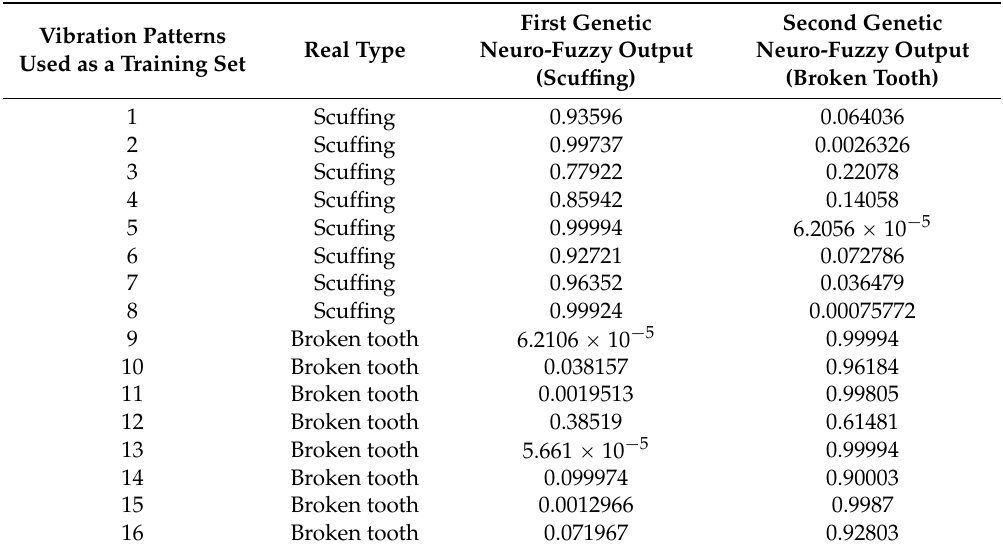
Table 3. Output values of the Genetic Neuro-Fuzzy system for the training set.